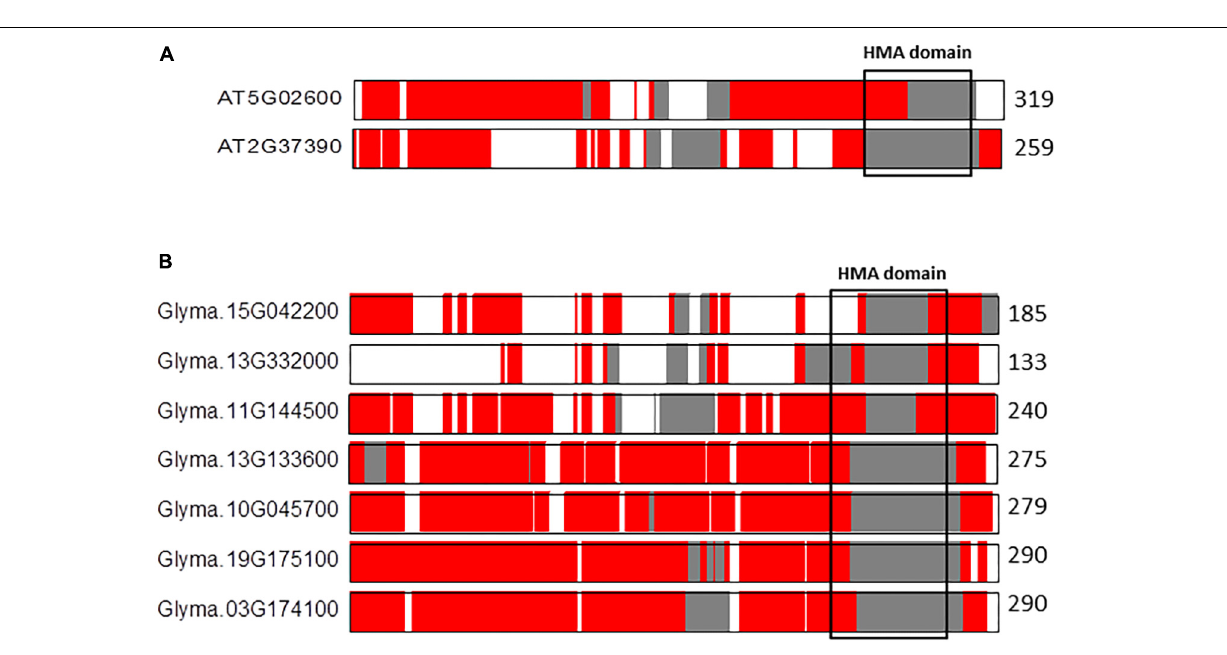
FIGURE 5 | Alignments of the co-linear NAKR1 paralogs in A. thaliana (A) and G. max (B) . The protein length is given to the right of each sequence. Sequences are represented by color coded bars representing predicted disorder. Disordered residues are shown in red), ordered residues are shown in gray, and alignment gaps are shown in white. Typical DNA-binding domains are shown as black